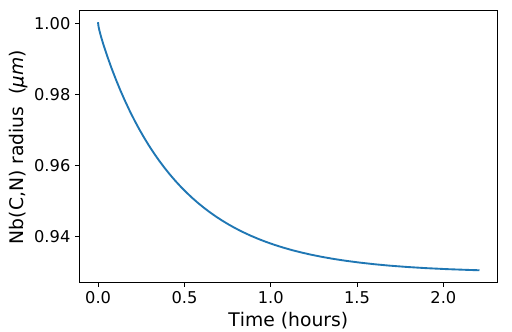
Figure 3. Nb(C,N) radius as a function of time during holding at 1473 K (nine-element calculation (full composition) using the TCFE9 database).